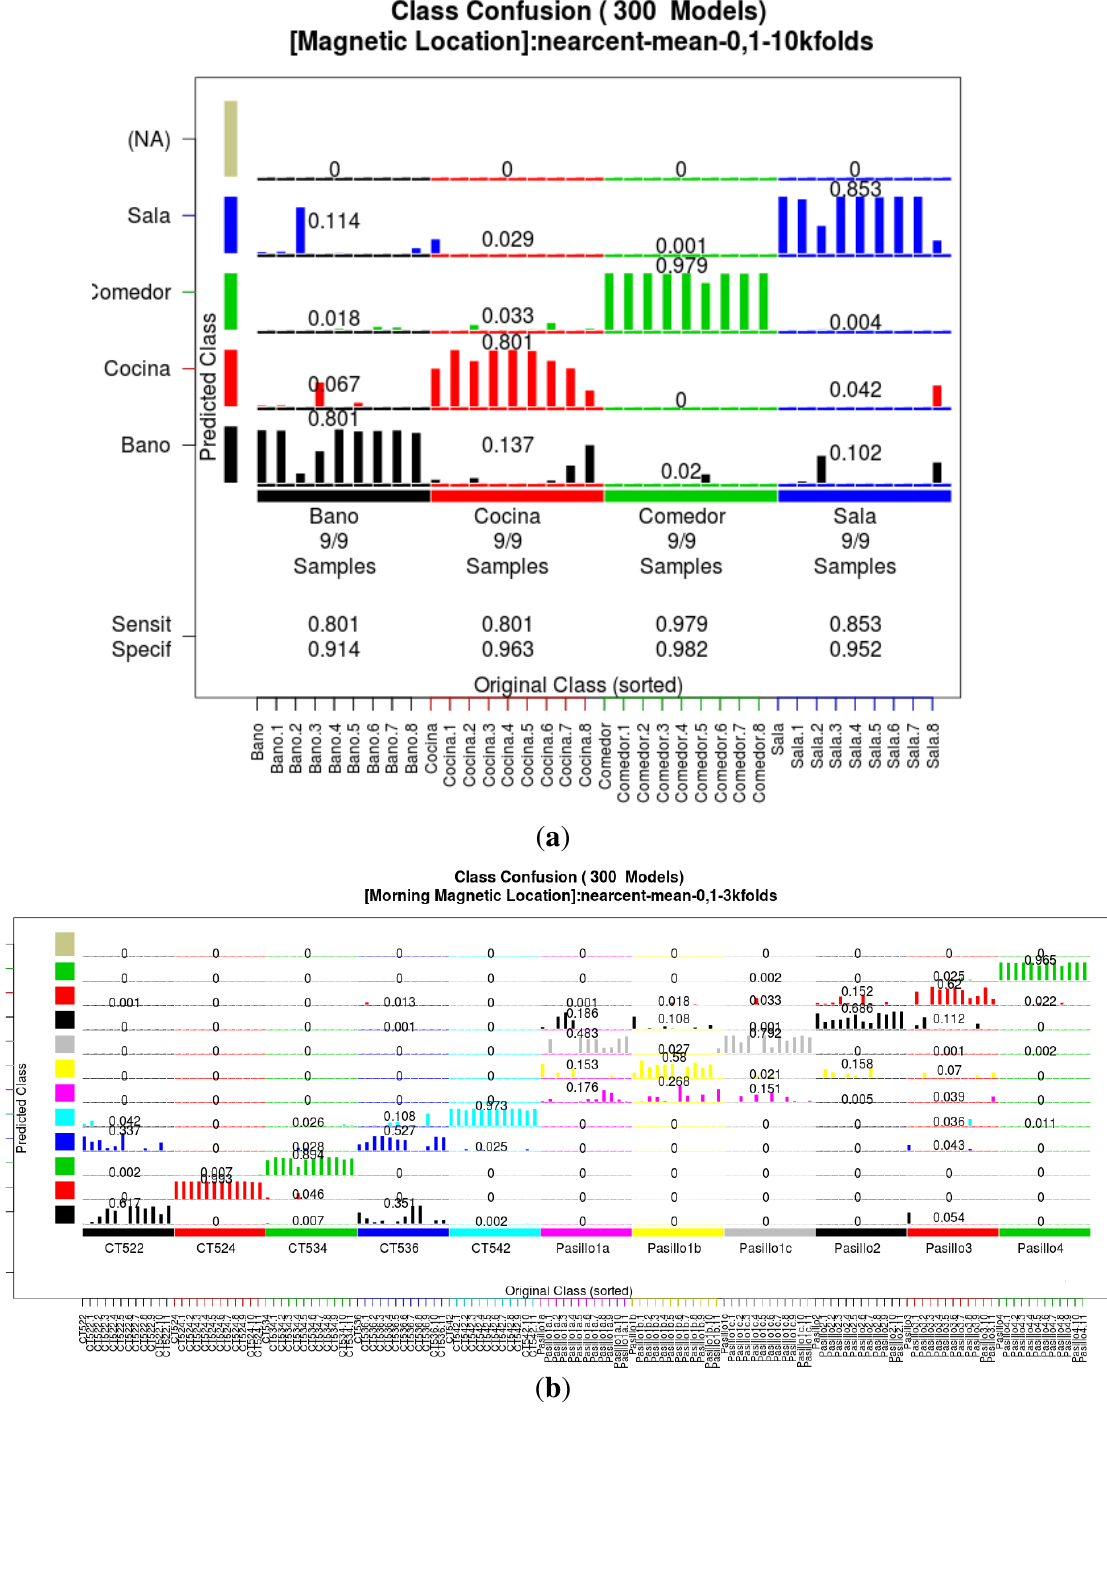
Figure 6. Confusion plot of the models; ( a ) residential home scenario; ( b ) office building